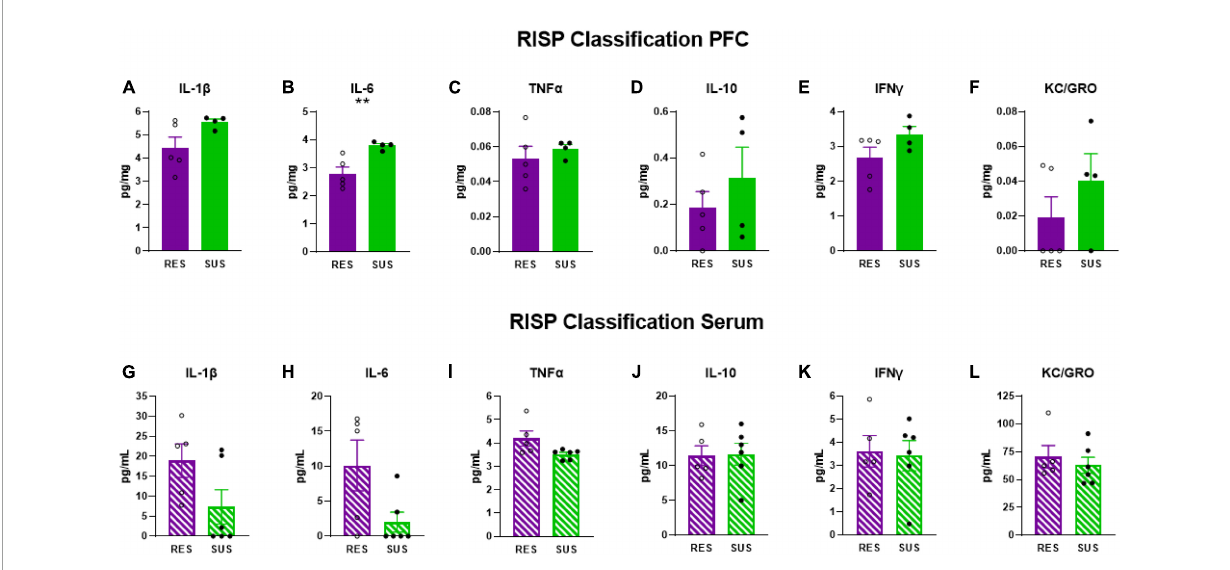
FIGURE2 IL-1 β , IL-6, TNF α , IL-10, IFN γ , and KC/GRO levels in PFC and serum based on RISP classification (PFC: Res n = 5, Sus n = 4, Serum: Res n = 5, Sus n = 6). Protein levels of IL-1 β , IL-6, and TNF α are in pg/mg for PFC and in pg/mL for serum. ** p <